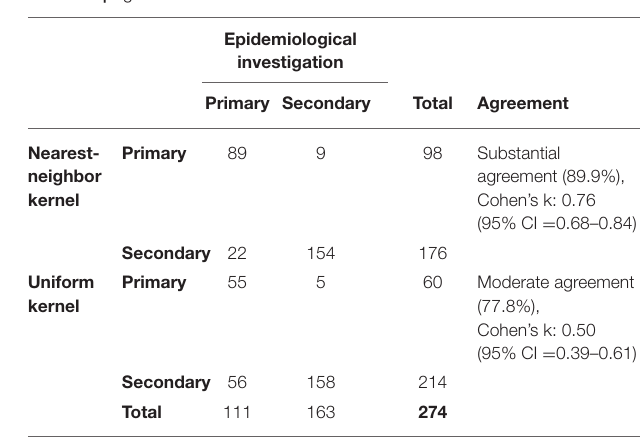
TABLE 3 | Agreement table